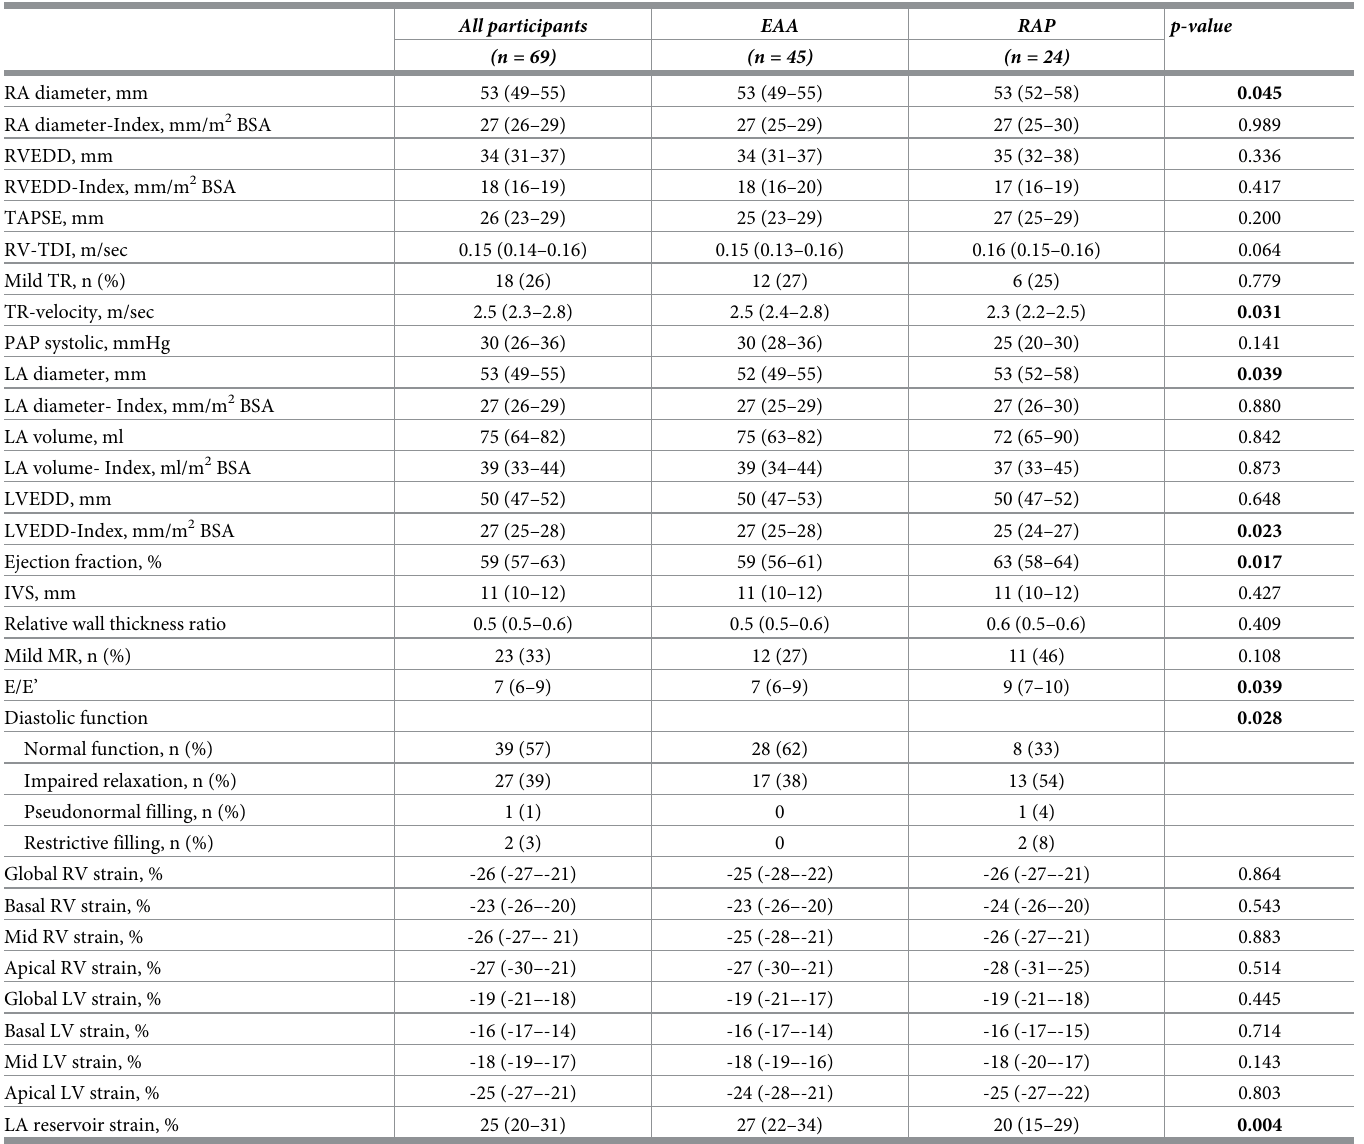
Table 2. Echocardiographic